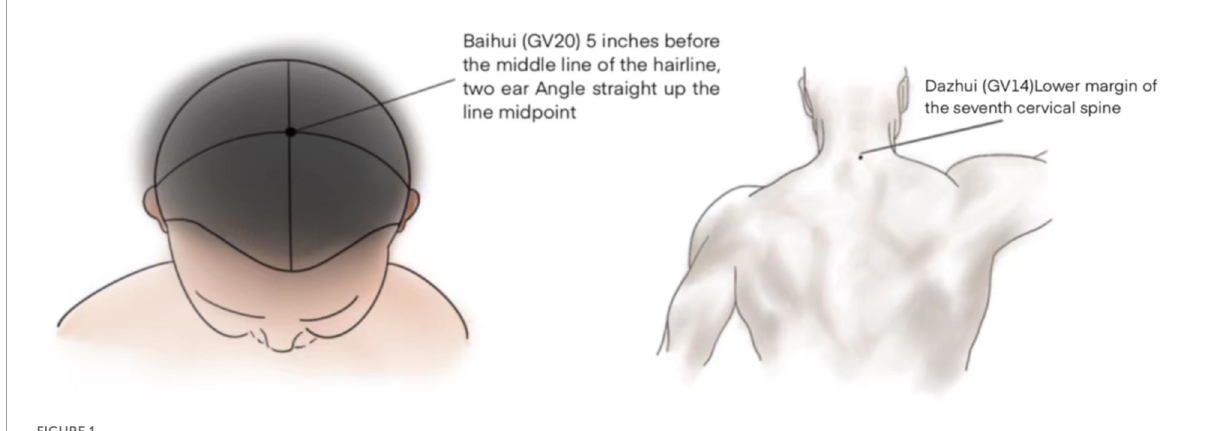
FIGURE1 Location of